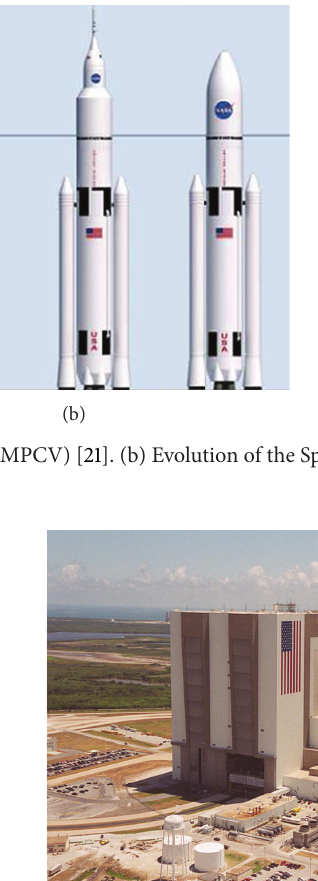
Figure 5: The Vehicle Assembly Building (VAB) was built for the Apollo program. The VAB was designed to house the assembly and final checkout of the 110-meter-tall Saturn V launch vehicle. One of the VAB’s most notable features is its 139-meter-high doors. It was also used for the assembly/stacking of the NASA Space shuttle. The VAB will be used for the assembly/stacking of the SLS and the MPCV. Photo courtesy of